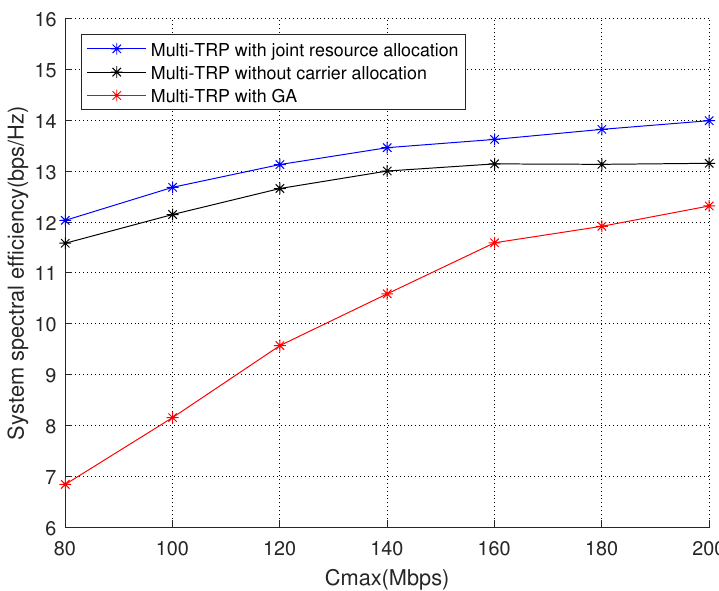
Figure 5. Performance comparison between the proposed algorithm and